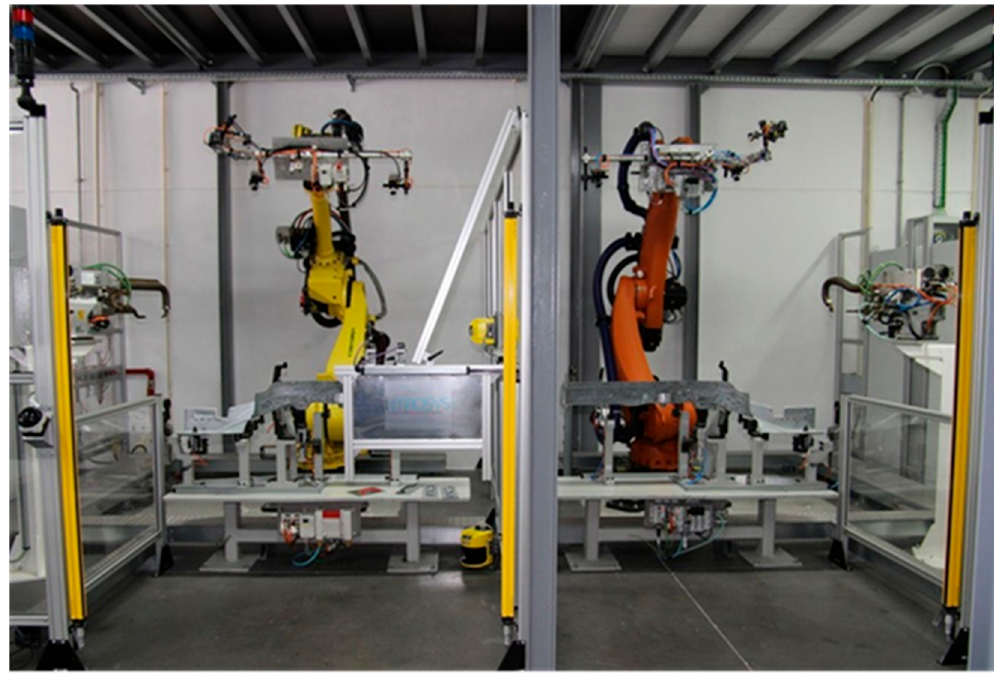
Figure 6. Introsys Welding Industrial Robotic Cells.